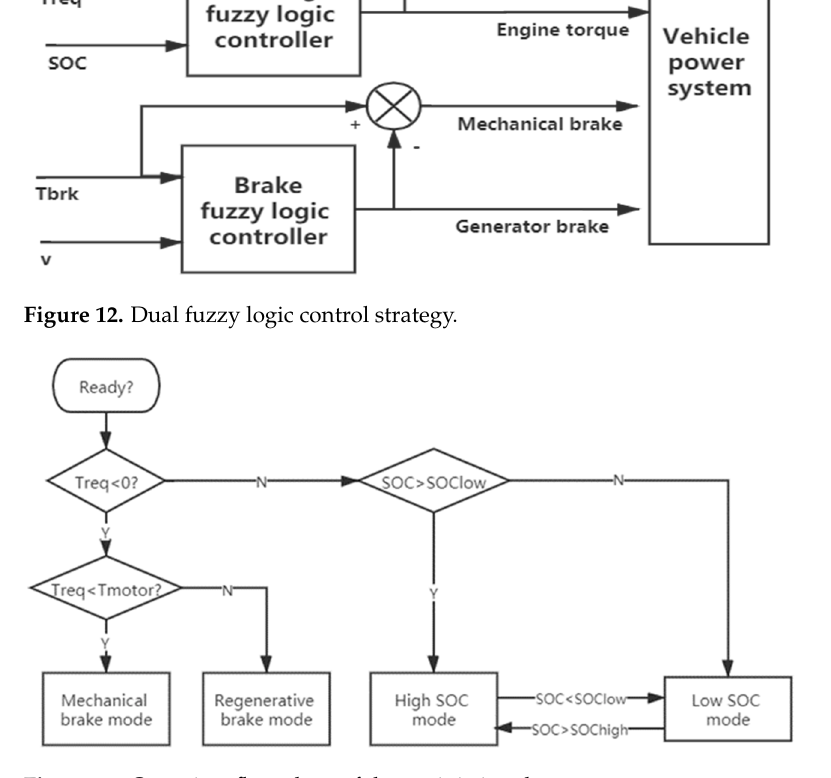
Figure 13. Overview flow chart of deterministic rules.